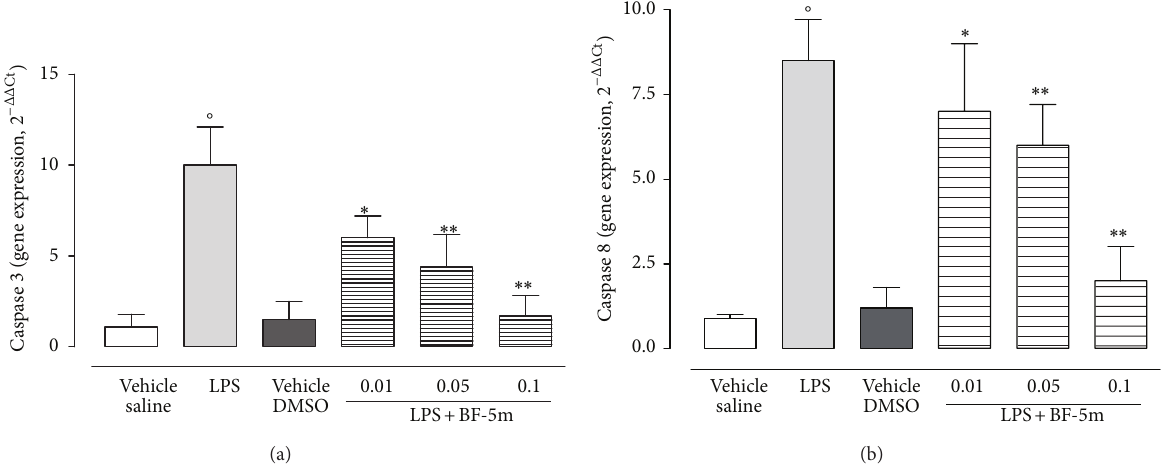
Figure 10: RT-PCR analysis for caspase 3 and caspase 8. Caspase 3 and caspase 8 in ocular tissue following treatment with BF-5m (0.01; 0.05; 0.1 𝜇 M/rat). Total RNA was extracted from the eye of vehicles, LPS, and BF-5m rats and reverse transcribed into cDNA using Superscript reverse transcriptase system. The expression of caspase 3 and caspase 8 was quantified by qPCR using commercially available rat primers. HPRT was used as internal control. Results are expressed as arbitrary units based on calculation of 2 −ΔΔ Ct method. Relative amount of target genes were normalized to HPRT and to vehicle. Results are expressed as the mean ± SEM of 𝑛 = 6 observations for each group. ∗ 𝑃 < 0.05 and ∗∗ 𝑃 < 0.01 versus LPS-treated rats; ∘ 𝑃 < 0.01 versus vehicle saline